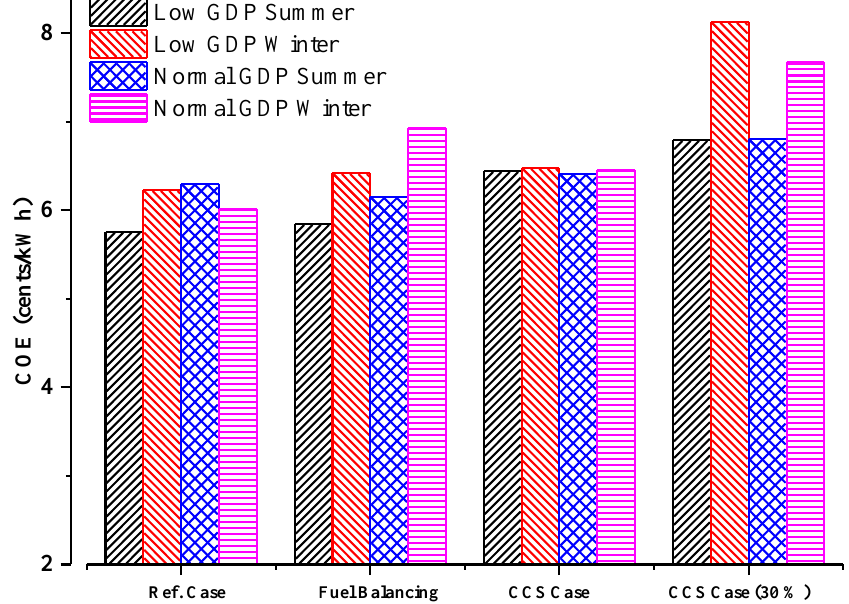
Figure 17. Average cost of electricity comparison for all cases.